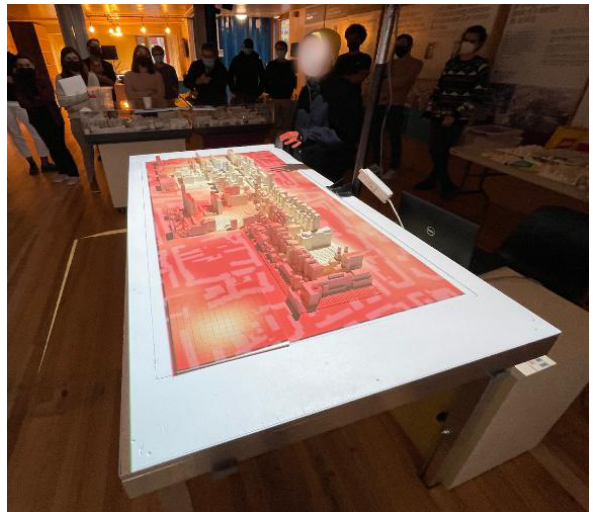
Figure 11. One image of the slideshow projected onto the tangible